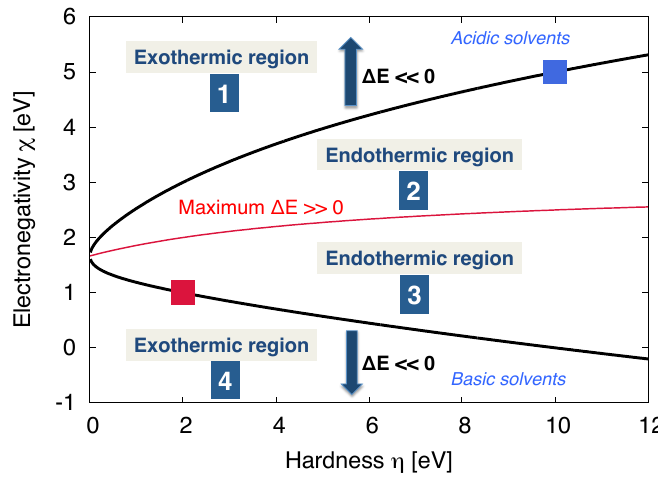
Figure 4. Endothermic ∆ E AB > 0 and exothermic ∆ E AB < 0 regions for solvents with distinct hardnesses η S and electronegativities χ S in combination with a cation (blue square) with arbitrary values of η A = 10 eV and χ A = 5 eV and an anion with arbitrarily chosen values of η B = 2 eV and χ B = 1 eV (red square). The red solid line denotes the maximum value for an endothermic reaction energy as defined for a solvent with χ max (Equation (23)). The black solid lines denote the separatrices S for values of ∆ E AB = 0. Figure reproduced from Ref.